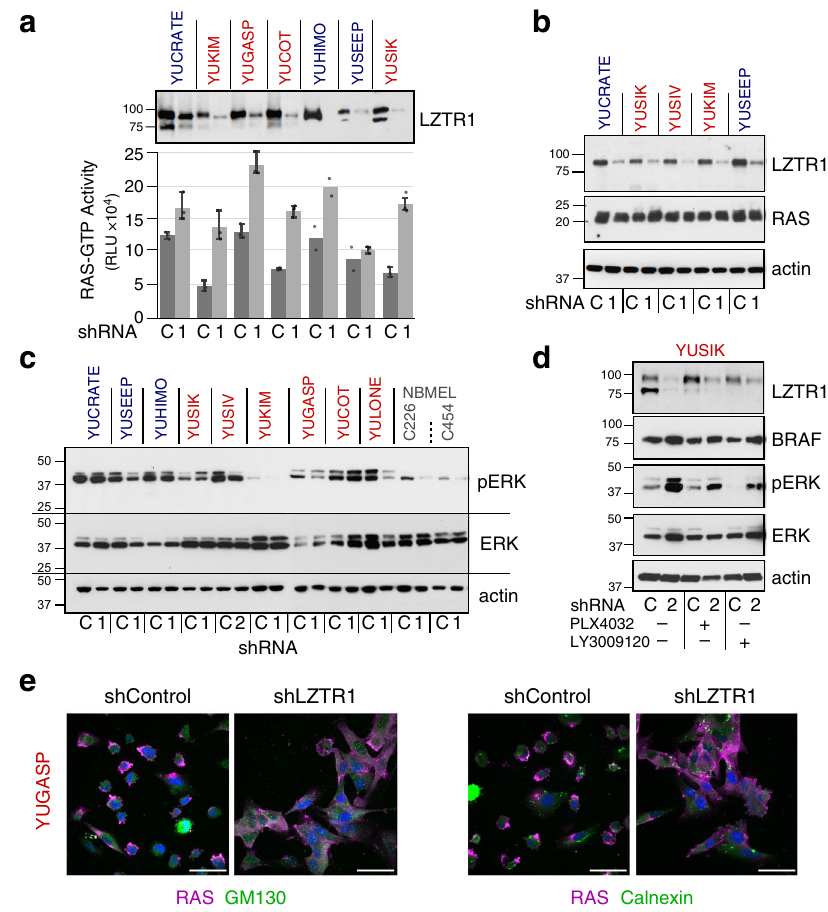
Fig. 4 Changes in cell signaling in response to LZTR1 knockdown. a , b Impact of LZTR1 loss on a RAS-GTP activity as measured by RAS-GTPase activation ELISA assay, and b RAS levels, 5 days after shLZTR1 infection. Data in a are expressed as the average of triplicate or duplicate wells with error bars indicating 95% con fi dence intervals. LZTR1 knockdown showed a statistically signi fi cant increase of RAS-GTP activity ( P = 0.006; two-sided, unpaired Wilcoxon rank-sum test). c Effect of LZTR1 loss on MAPK activity. d YUSIK melanoma cells were incubated with the PLX4032 (500 nM) or LY3009120 (100 nM), BRAF, and pan-RAF kinase inhibitors, respectively, for 4 h at the end of treatment with LZTR 1 shRNA. e RAS translocation to the cytoplasm in response to shLZTR1 . RAS is visualized by staining with magenta, and GM130 or calnexin with green (Cy2). Scale bar = 50 µ m. shRNAs are indicated in panels a – d by numeric identi fi ers; C scrambled shRNA control. Actin levels in a – d show protein loading. Cell lines indicated above the plots are colored according to their origin: acral melanoma (blue), sun-exposed melanoma (red), and normal melanocytes (gray). NBMEL newborn melanocytes. Panels a , b , d, and e represent a single experiment; panel c represents one of two experiments. Source data are provided as a Source Data fi